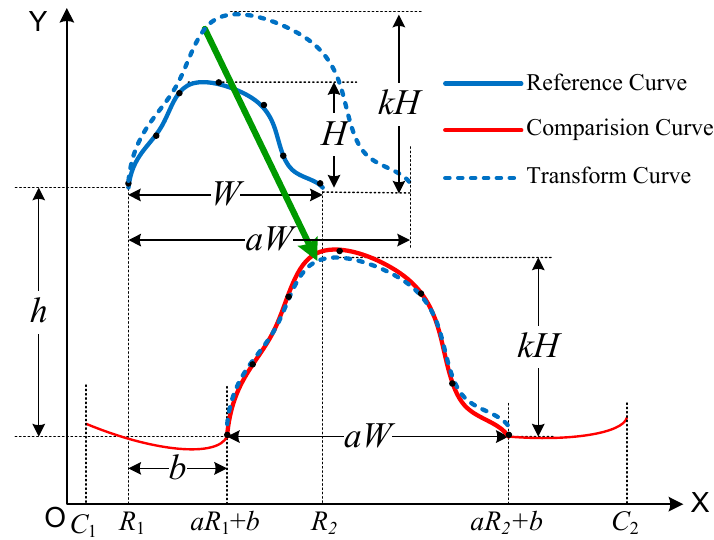
Figure 2. The curve similarity transformation between the two curves.